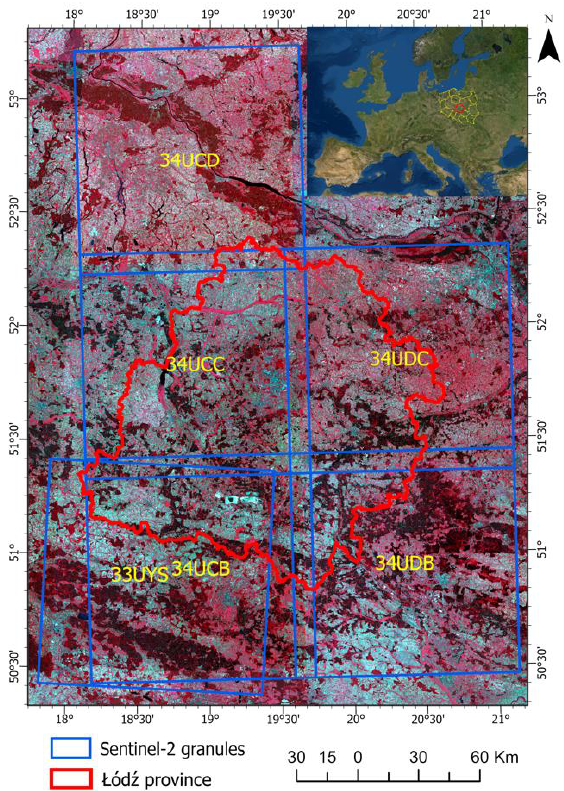
Figure 1. Location of the study site. Blue polygons indicate the extant of six Sentinel-2 granules (the colour composite: bands 8, 3 and 2) with the red outline of the Łódź province.